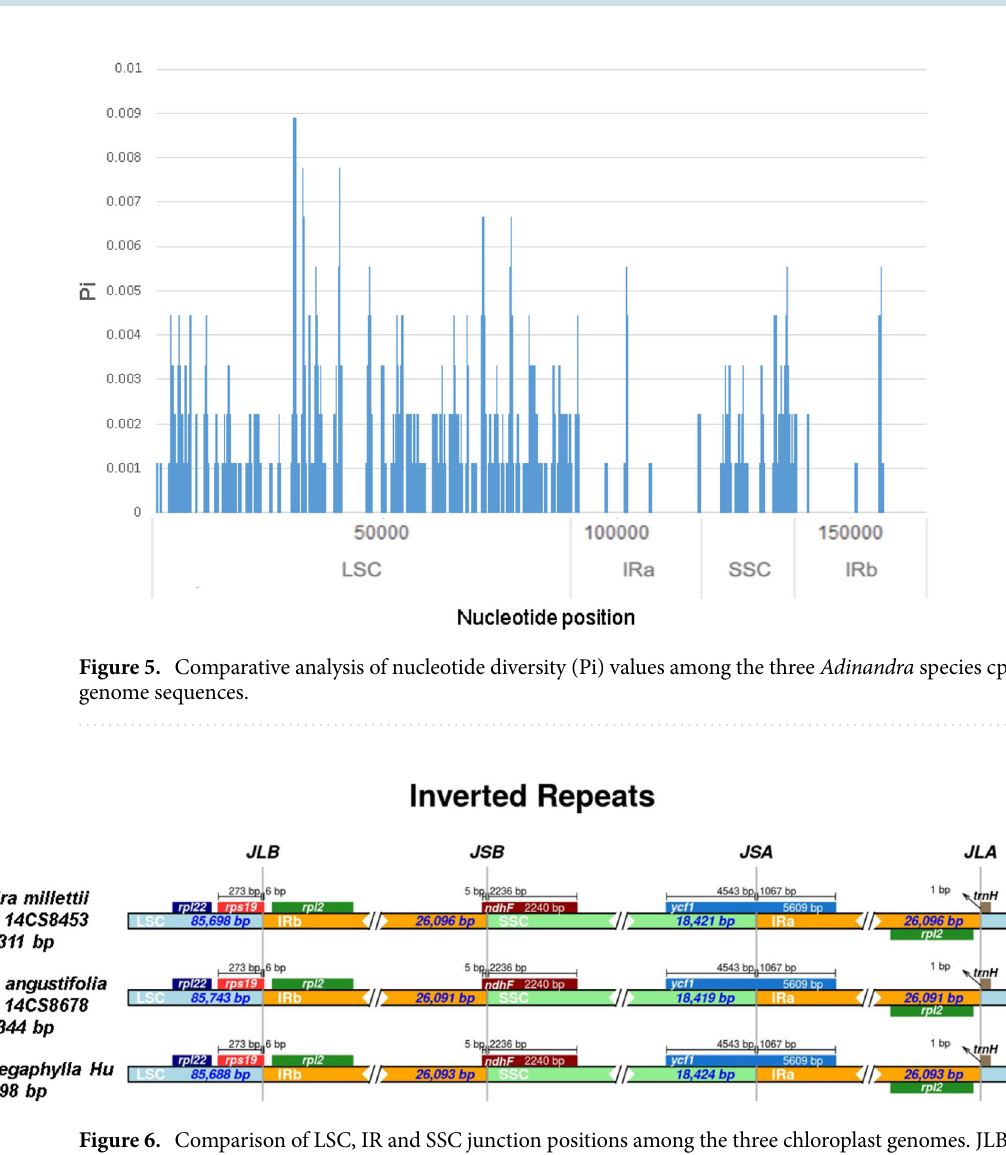
Figure 6. Comparison of LSC, IR and SSC junction positions among the three chloroplast genomes. JLB (junction IRb/LSC), JSB (junction IRb/SSC), JSA (junction IRa/SSC), JLA (junction